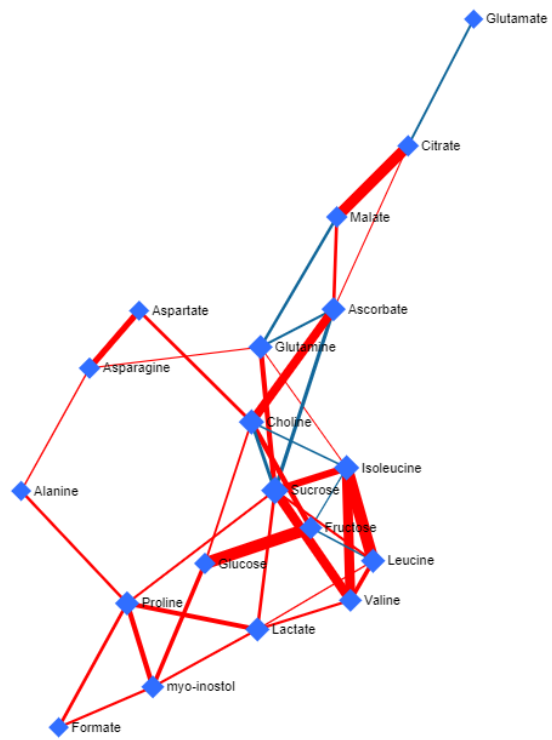
Figure 5. Partial correlation network constructed using the 20 identified metabolites in lemon peel. The size of the nodes represents the direction of change, and colored borders indicate a p -value < 0.05 and a false discovery rate (FDR)-adjusted p -value < 0.2. Red and blue borders indicate positive and negative correlations,